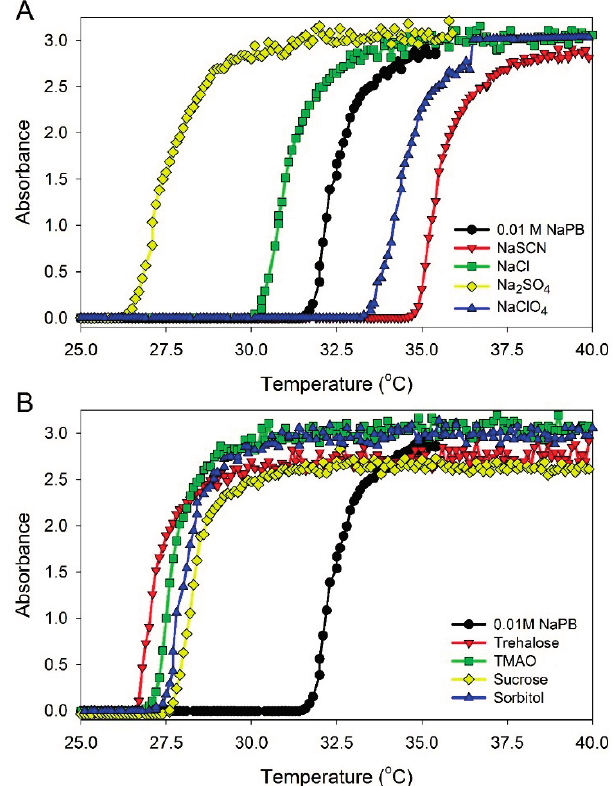
Figure 3. UV absorbance at 350 nm of (GVGVP) 40 at 0.90 mM concentration in 0.01 M sodium phosphate buffer (NaPB), pH 7.4 in the presence of different additives as a function of temperature. Additives: ( A ) salts—0.1 M NaCl, 0.05 M Na 2 SO 4 , 0.1 M·NaClO 4 , and 0.1 M NaSCN; and ( B ) osmolytes—0.5 M sucrose, 0.4 M sorbitol, 0.4 M trehalose,